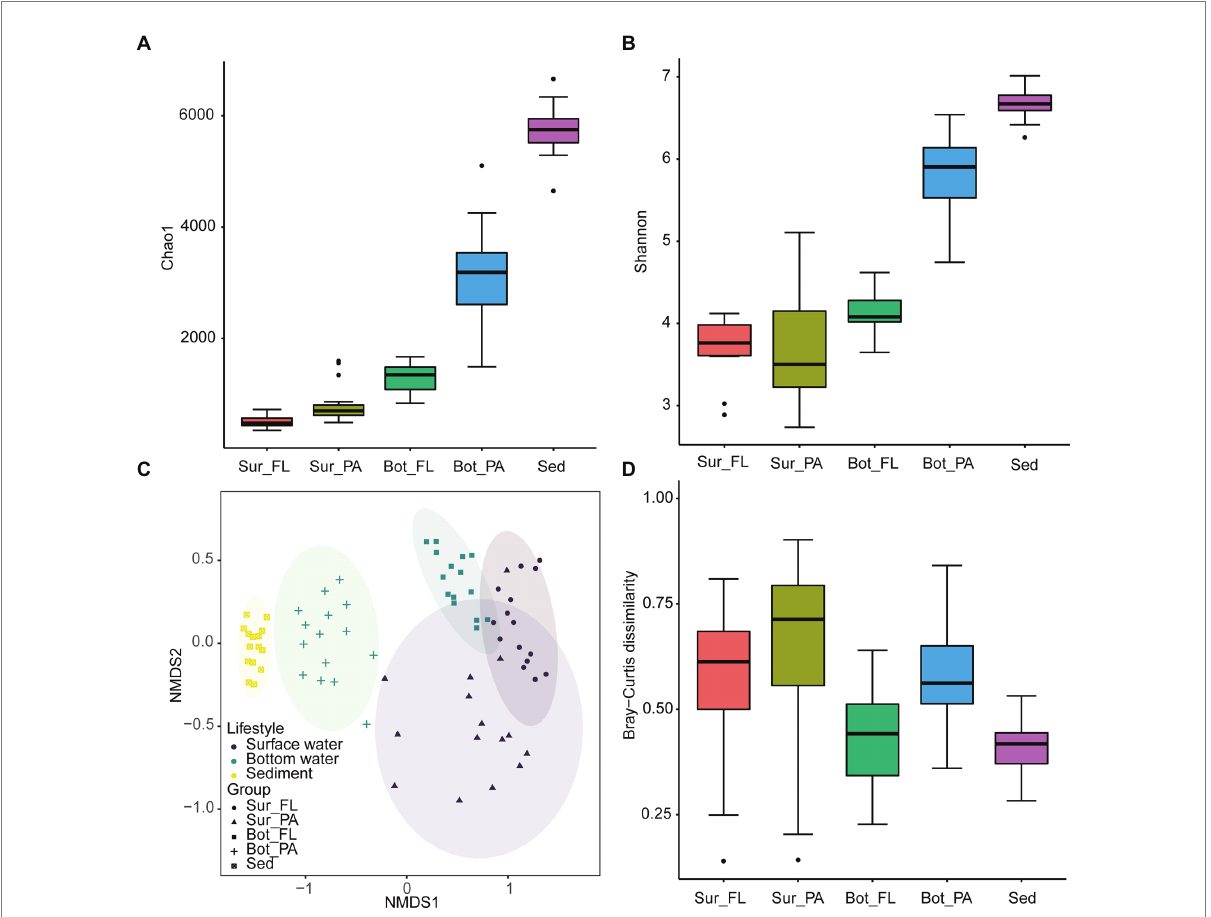
FIGURE 4 Alpha and beta diversity of microbial communities at the OTU level. (A) Chao1 index of different communities; (B) Shannon index of different communities; (C) NMDS plot of different communities; (D) Beta diversity index of different